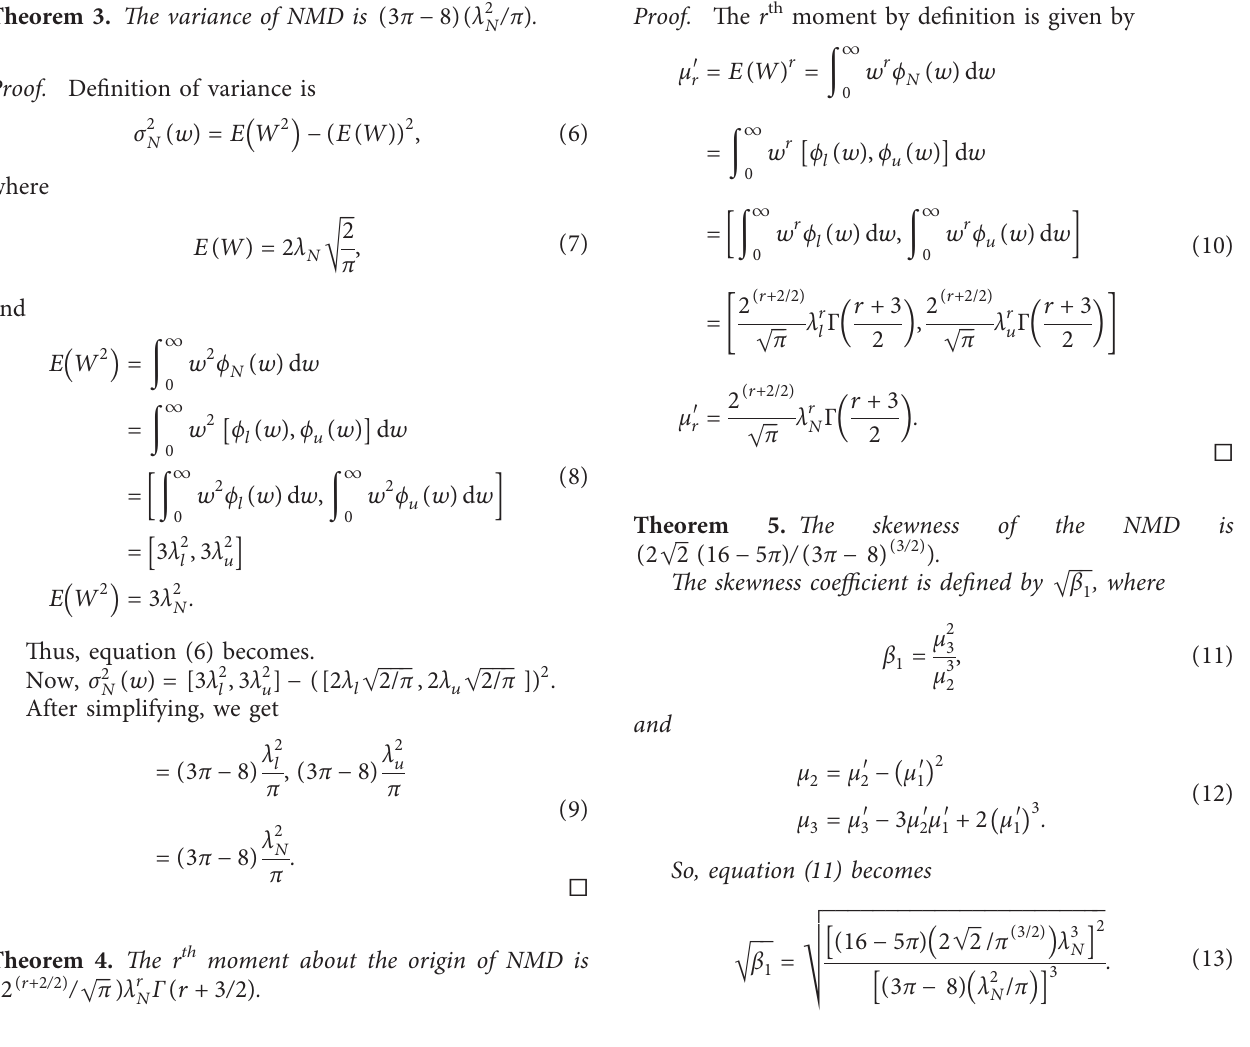
� ( 1 , 1 . 5 ) . (b) λ � ( 2 , 2 . 5 ) N . (a) λ N N